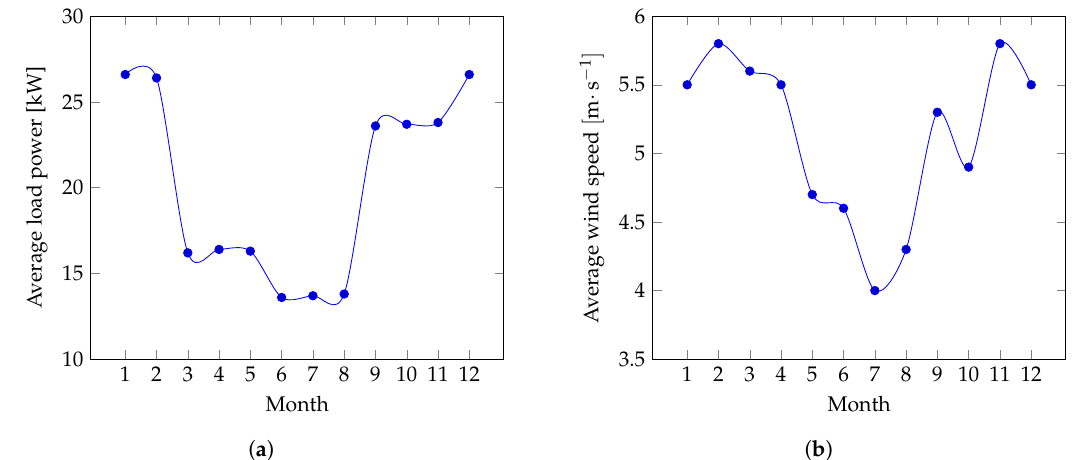
Figure 2. Load and wind data in Esker Camp: ( a ) annual average load profile; ( b ) average wind speed per